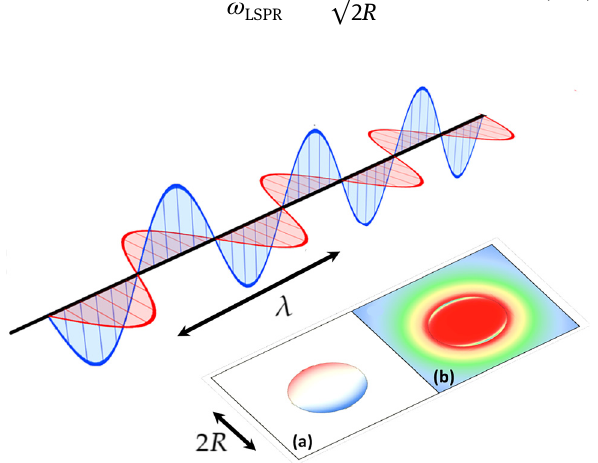
Figure 6: Schematic illustration of excitation of sub-wavelength metallic disk, R ≪ 𝜆 , with the E -field (in red) polarized in the horizontal plane. (a) Induced charge density 𝜚 ( r ) of the dipole resonance and (b) corresponding norm of the electric